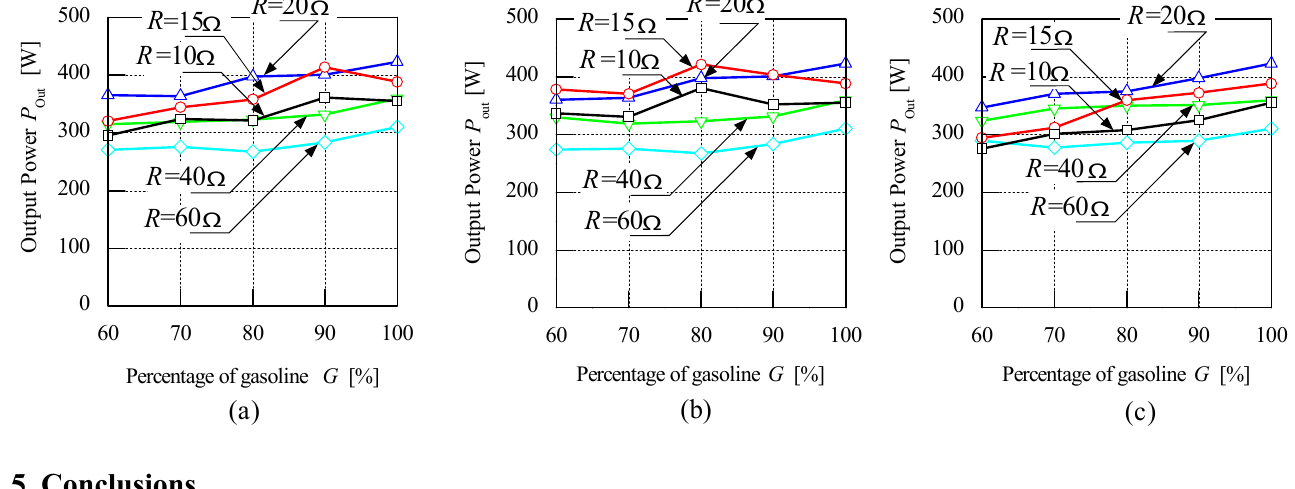
Figure 8. Electrical characteristics of bio-fuel/gasoline with different blending ratios: ( a ) Ethanol; ( b ) Butanol; ( c )